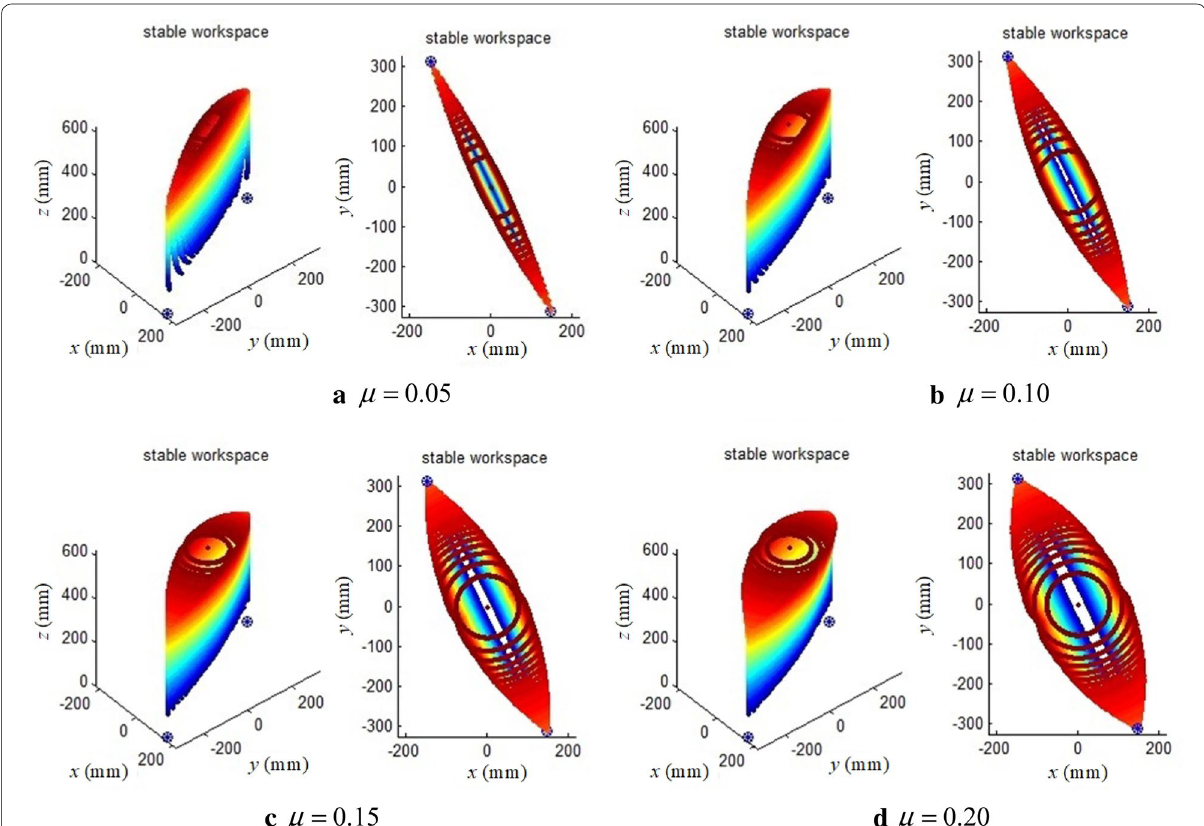
Figure 16 Stable workspaces of equivalent mechanism under different friction